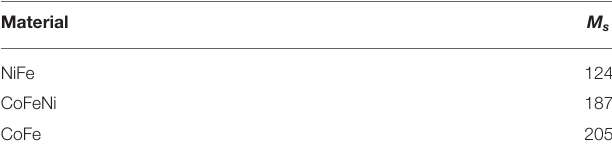
TABLE 1 | Saturation magnetization values measured by SQUID for MNPs anchored on